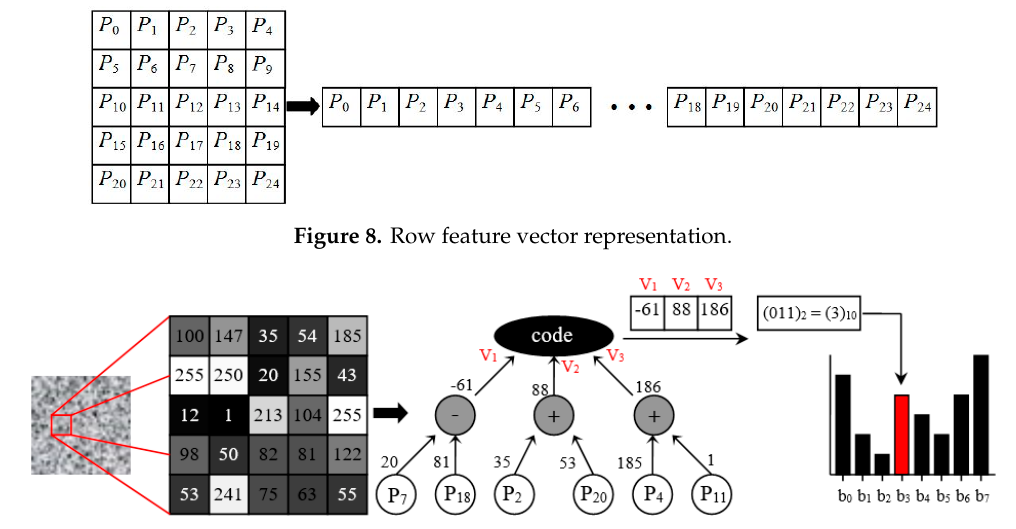
Figure 9. ABCP program representation.